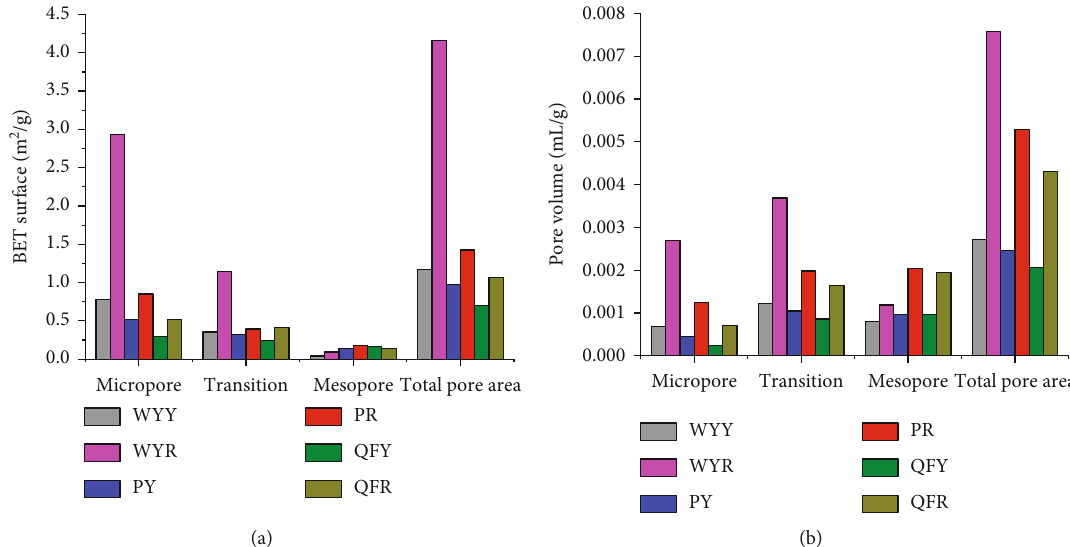
Figure 4: Pore size distribution of coal samples by N coal